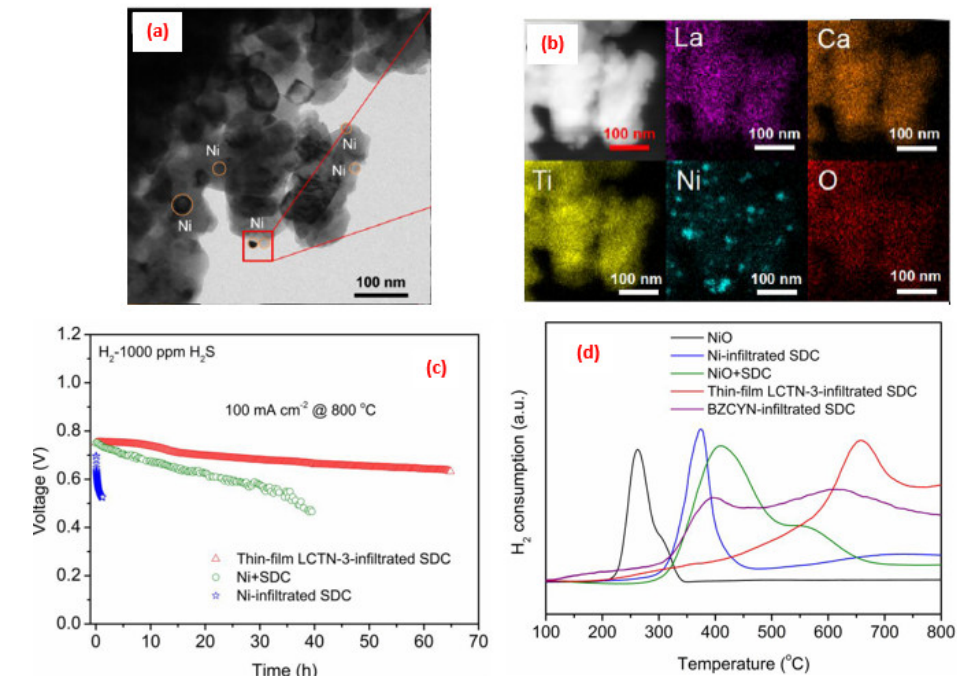
Figure 8. ( a ) Transmission Electron Microscopy image of reduced La 0.33 Ca 0.47 Ti 0.94 Ni 0.06 O 3 − δ powder; ( b ) Scanning transmission electron microscopy-Energy dispersive X-Ray results of reduced LCTN–3 powder; ( c ) stability test of the fuel cells with Ni-infiltrated SDC, Ni + SDC, and reduced thin-filmLCTN–3-infiltrated SDC anodes operating on H 2 – 1000 ppm H 2 S; and ( d ) H 2 -TPR profiles of the Ni-infiltrated SDC, NiO + SDC, thin-film LCTN–3-infiltrated SDC, and Ba(Zr 0.4 Ce 0.4 Y 0.2 ) 0.8 Ni 0.2 O 3 − δ -infiltrated SDC anodes and NiO. Copyright 2018 by the American Chemical Society [92].